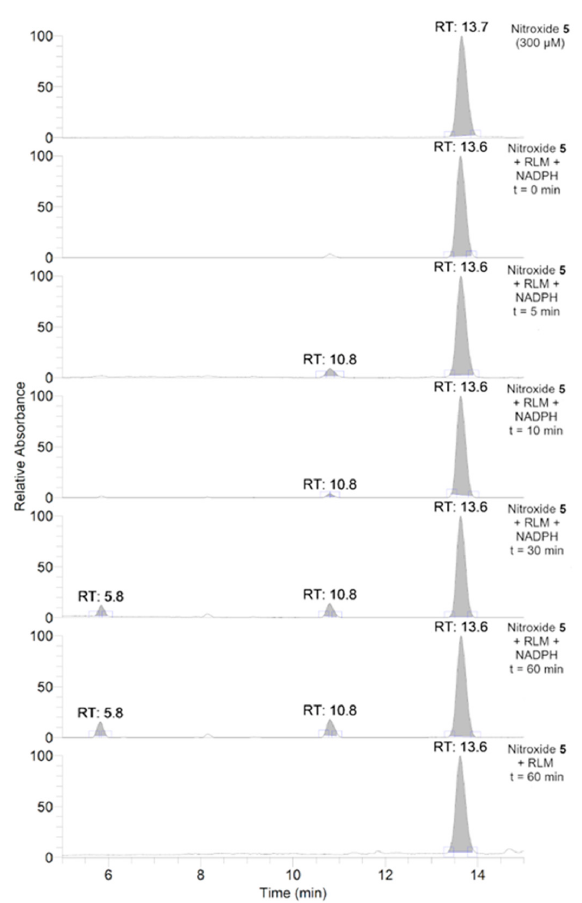
Figure 2. Total scan UV-Vis chromatograms of the incubations of nitroxide 5 (300 μ M) in RLM (7.8 mg·ml − 1 protein, 30 μ M P450) with or without NADPH (2 mM) in potassium phosphate buffer (100 mM, 𝑝𝐻 7.4) upon anaerobic conditions. Samples were prepared and analyzed as described in the experimental section.